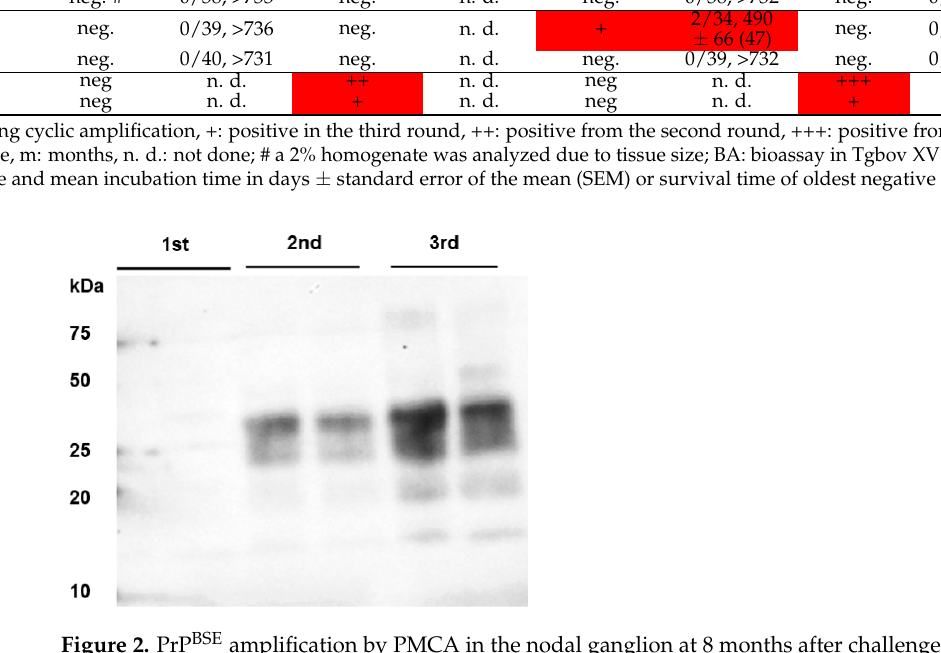
Figure 2. PrP BSE amplification by PMCA in the nodal ganglion at 8 months after challenge. From the third round of PMCA, seeding activity was shown in the nodal ganglion from animal IC 02 (8 mpi); this sample was analyzed in duplicate and subjected to 4 rounds of PMCA; M: marker. Table 2. Results for peripheral nervous tissues closer to the brain were achieved by PMCA and Tgbov XV mouse bioassay. Time Point Post Animal ID Inoculation